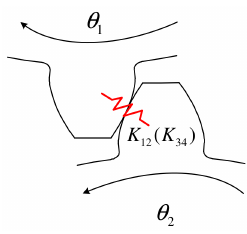
Figure 5. The relative motion of gear